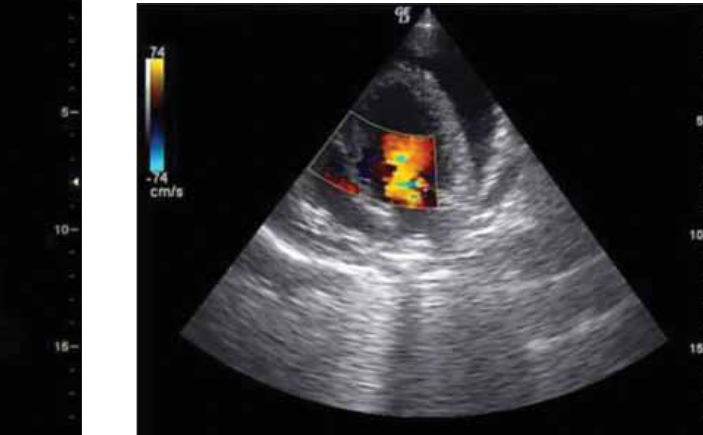
Figure-8: Regurgitation at the level of mitral valve.